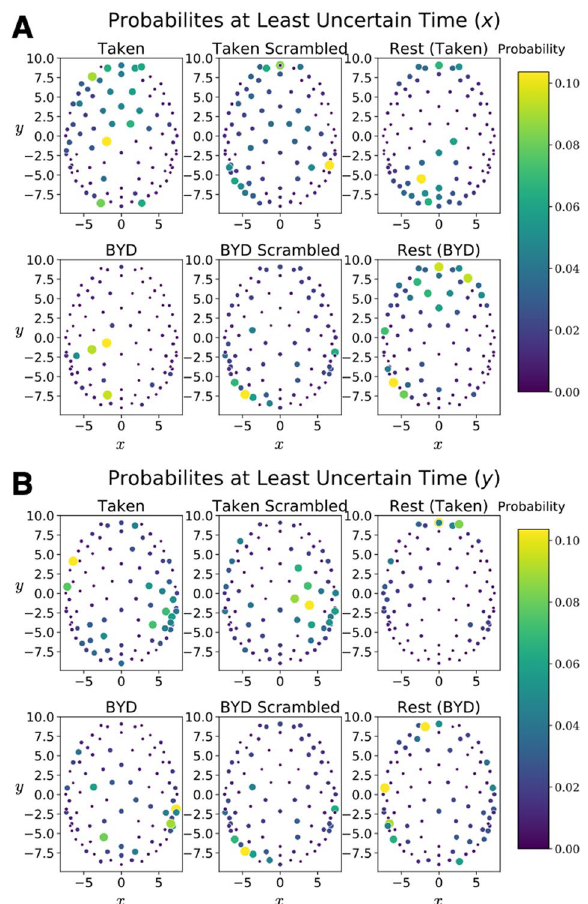
Figure 3. Probability maps corresponding to the least uncertain time point for each of the six experimental conditions. ( A ) The probabilities which lead to the minimum uncertainty as defined by the minimum of � x ( t )� p x ( t ) . ( B ) The probabilities which lead to the minimum uncertainty as defined by the minimum of � y ( t )� p y ( t ) . One subject is displayed for all Taken stimuli, and another for all Bang! You’re Dead